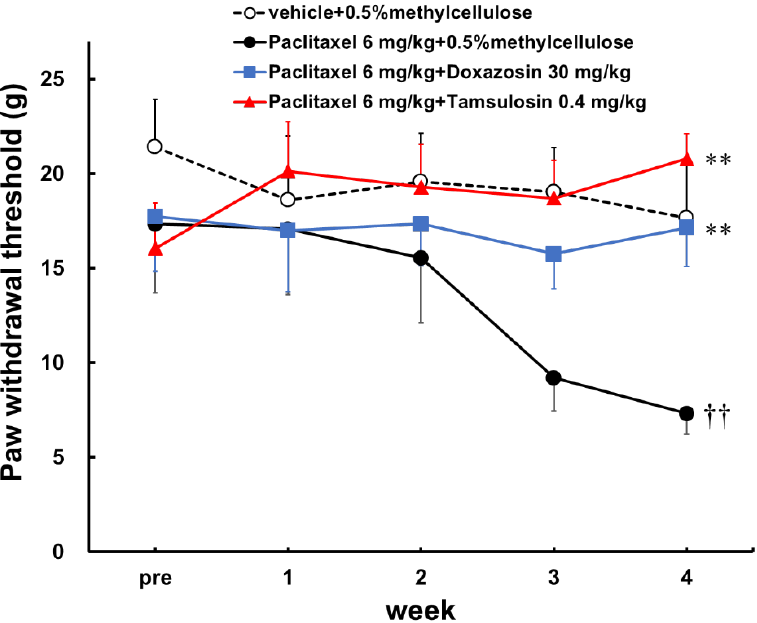
Figure 1. Effects of doxazosin and tamsulosin on paclitaxel-induced mechanical allodynia in SD rats. Paclitaxel (6 mg/kg) was administered intraperitoneally once weekly for 4 weeks. Doxazosin (30 mg/kg) and tamsulosin (0.4 mg/kg) were administered orally 5 times a week for 4 weeks. A von Frey test was performed before the first drug administration (pre) and then once a week. Threshold values were determined to be mean ± S.E.M. ( n = 6–8). †† p < 0.01 vs. vehicle + 0.5% methylcellulose; ** p < 0.01 vs. paclitaxel + 0.5% methylcellulose, one-way ANOVA followed by a Tukey – Kramer test.